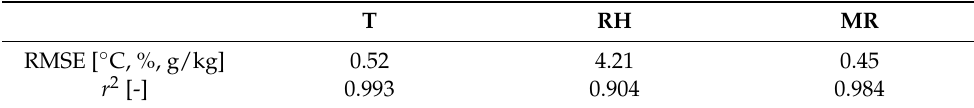
Table 6. Indexes RMSE and r 2 for T, RH, and MR of the validated model. T RH MR RMSE [ ◦ C, %, g/kg] 0.52